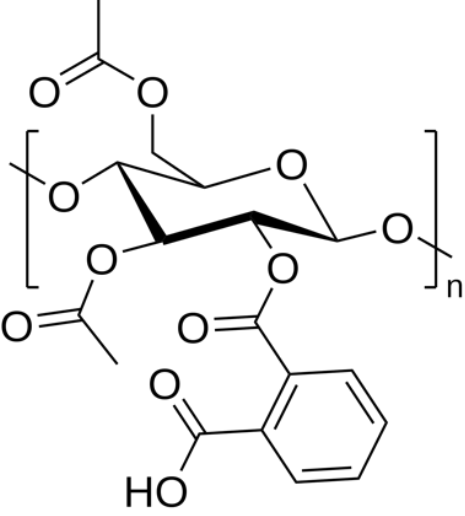
Figure 1. Represents the chemical structure of CAP [39].